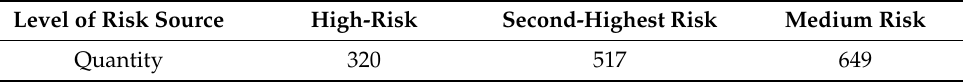
Figure 11. Risk levels of transportation in the cross-border zone. Table 6. Composition of risk sources in the transboundary regions.